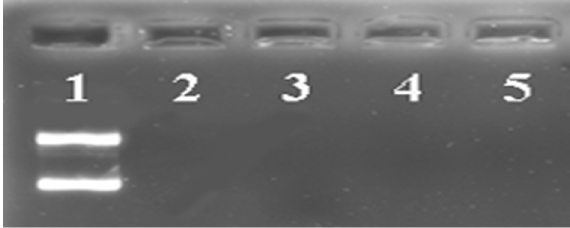
Figure 4. Gel retardation assay. Lane 1: DNA; lane 2 to 5, DNA/PEI/PPSD at ratios ( wt/wt/wt ) of 1:1:0, 1:1:8, 1:1:16, 1:1:32, respectively.